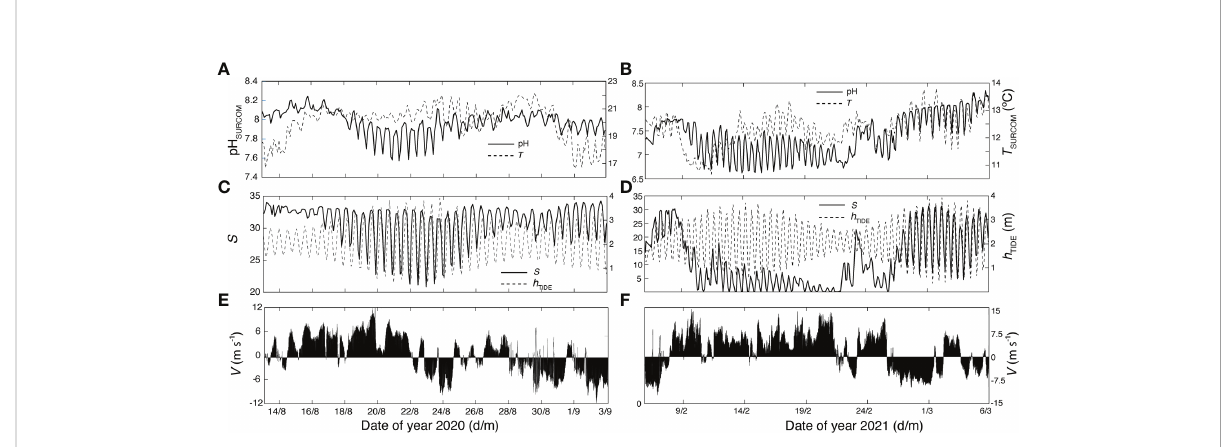
FIGURE 8 2-hourly mean bins during summer 2020 (left panels: (A , C , E) and winter 2021 (right panels: (B, D, F) of pH and temperature ( T SURCOM upper panels: A , B ), salinity ( S ) and tide height ( h TIDE ) (center panels: (C , D) and wind vectors ( V bottom plots: (E , F)